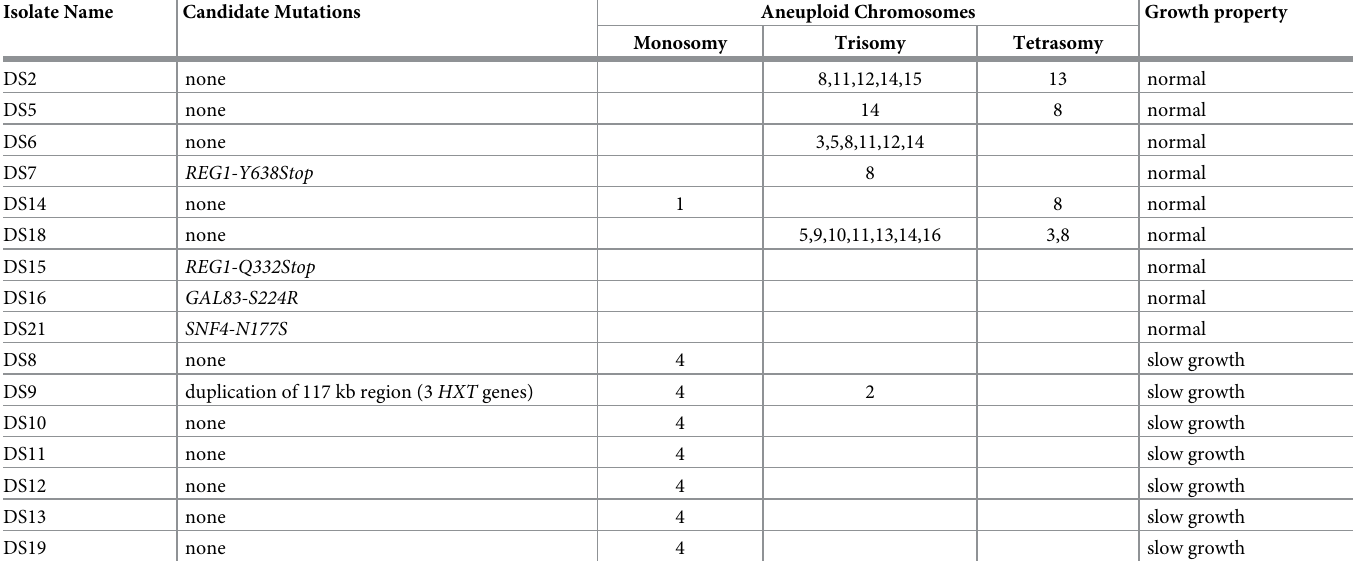
Table 2. Genomic Sequencing Results. Isolate